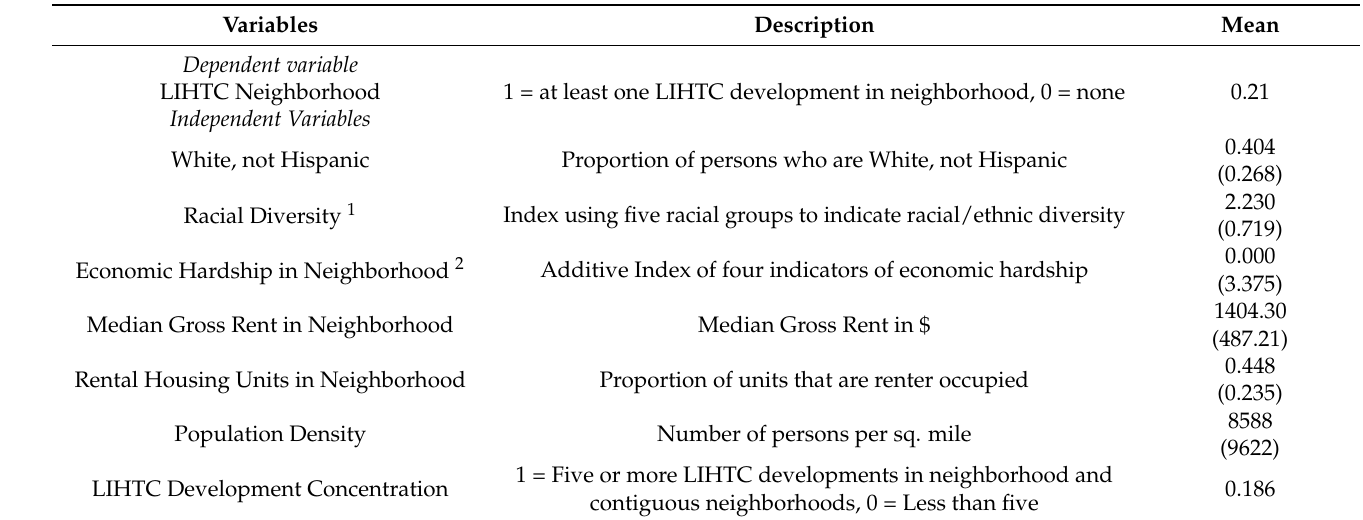
Table 4. Descriptive Statistics for Variables in the Model,